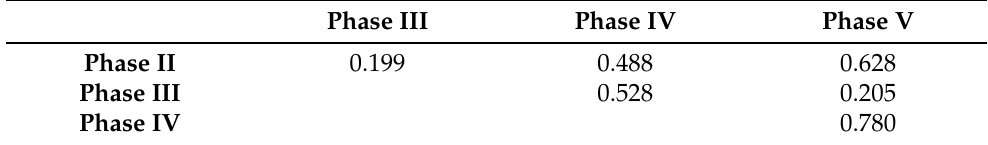
Figure 11. Scatter plots of the mean values of bacterial groups’ specific average log ratio changes. Half-matrix right top: mean value for each bacterial group in one phase against the other phases. Half-matrix left bottom: mean value for each bacterial pair in one phase against the other phases. Table 3. Correlation coefficients for bacterial groups’ specific average log ratio changes be- tween